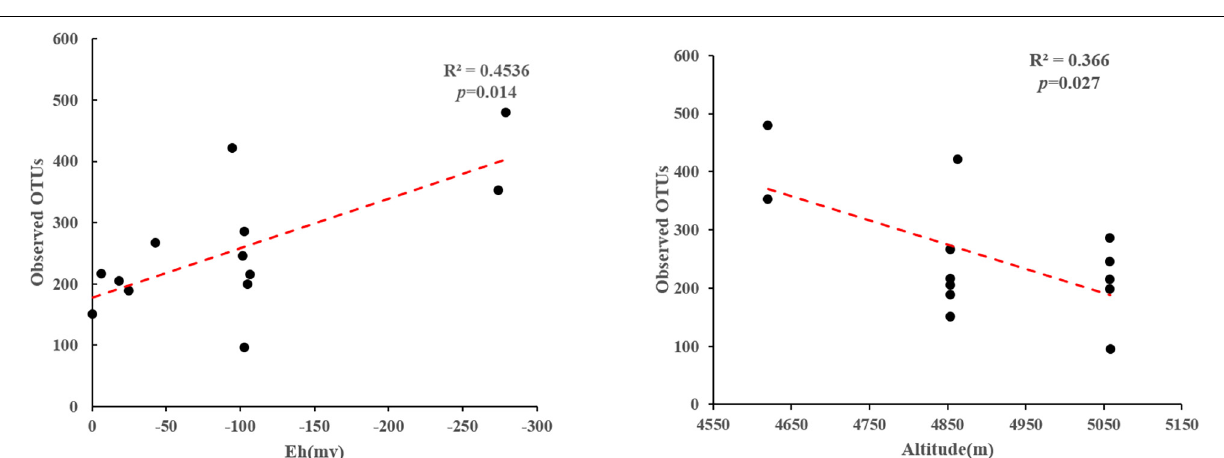
FIGURE 2 | Phylogenetic analysis of the obtained 16S rRNA (A) and hydA gene (B) sequences of the studied hot spring samples.